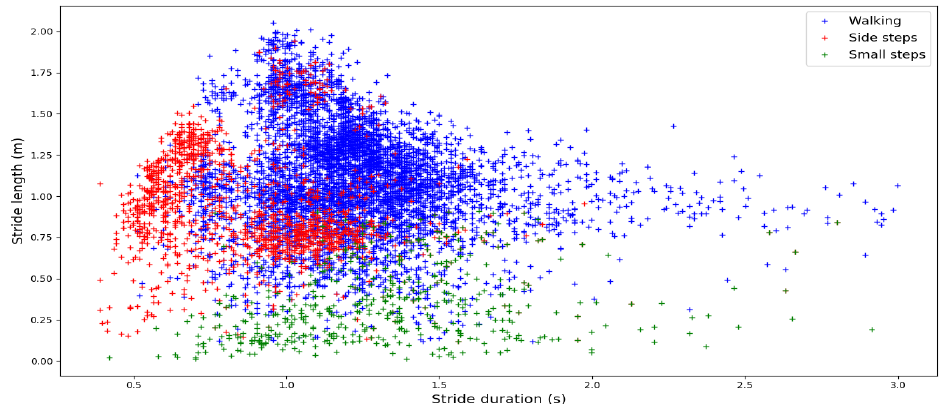
Figure 5. Stride length as a function of stride duration during MOCAP sessions.